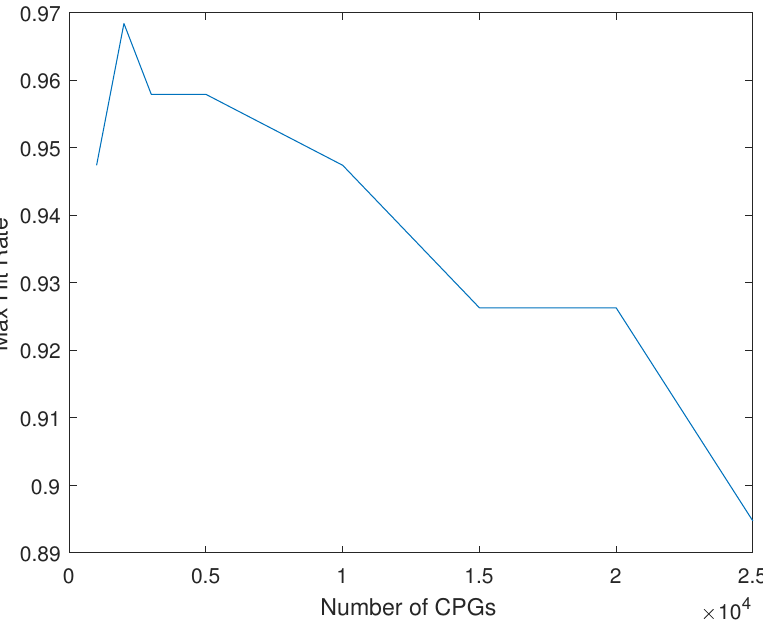
Figure 1. Max Hit Rate (HR) versus number of CpGs included in the